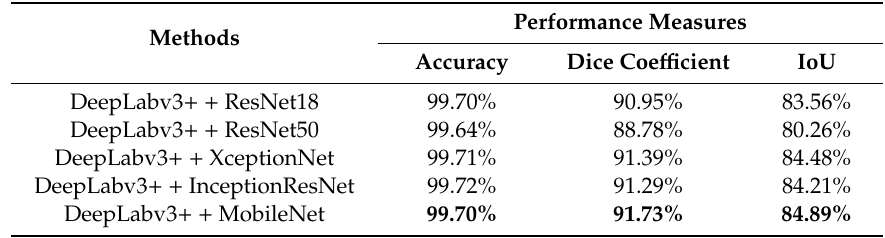
Table 4. Statistical performance of various deep semantic algorithms for two classes segmentation between OD and non-OD.